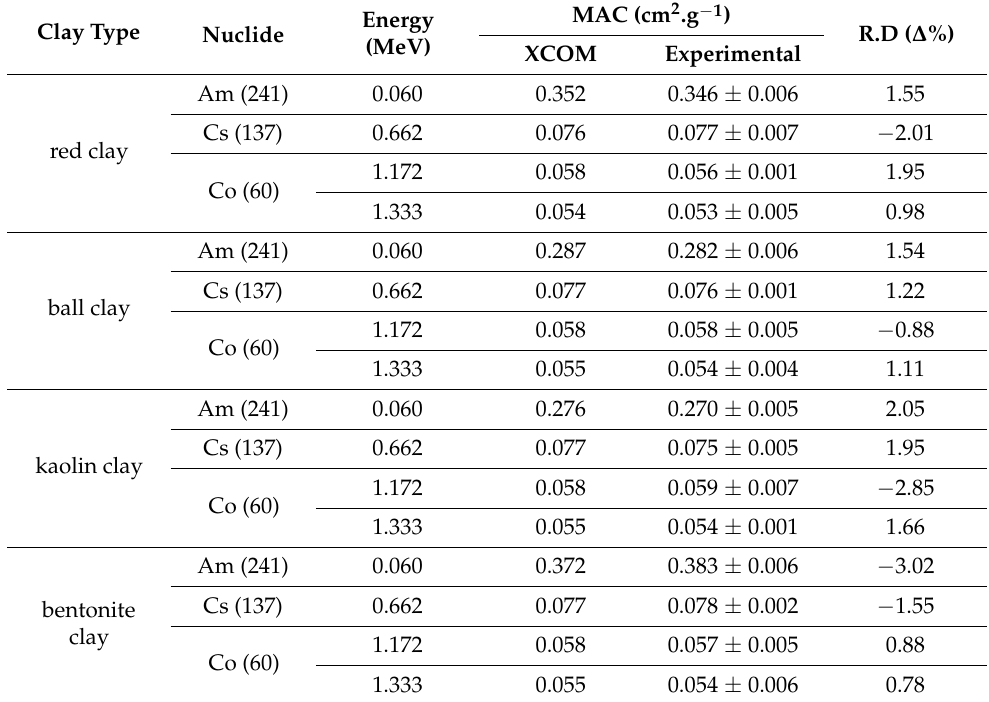
Table 2. The experimental and theoretical MAC by XCOM program as well as the relative deviation between the two